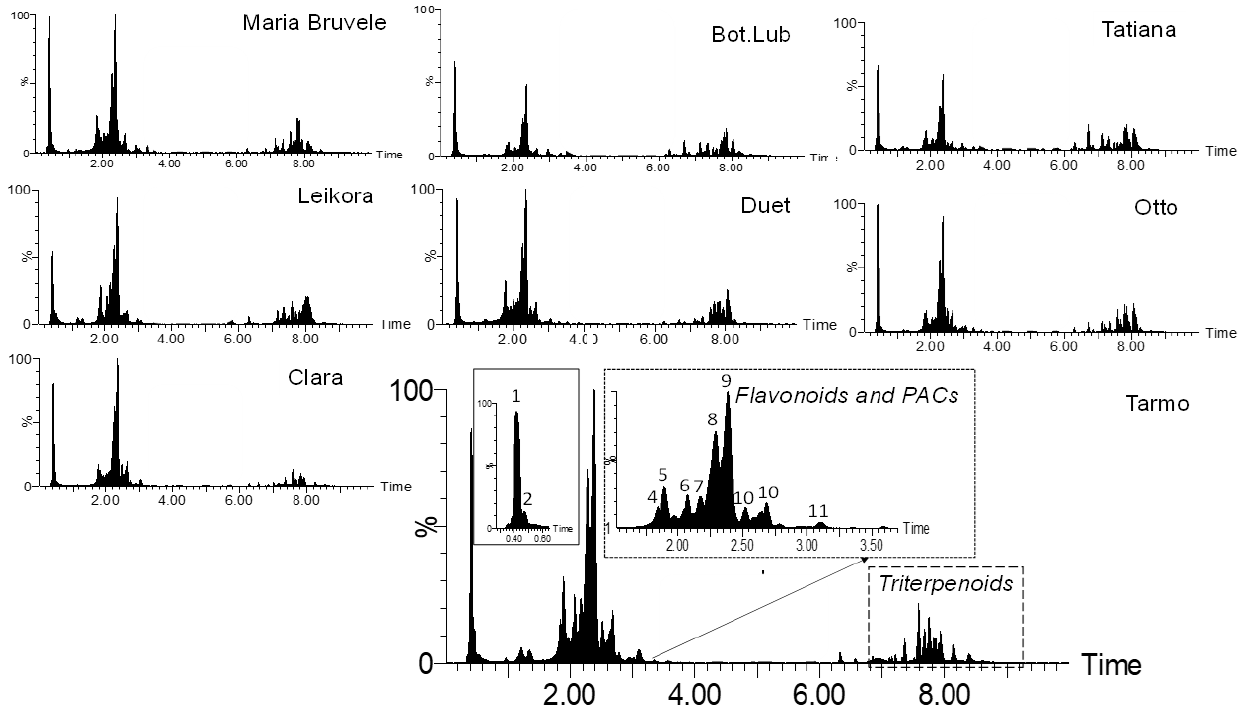
Figure 3. Comparison of the chemical composition of the sea buckthorn 50% EtOH extracts by UHPLC-TOF/MS chromatograms.